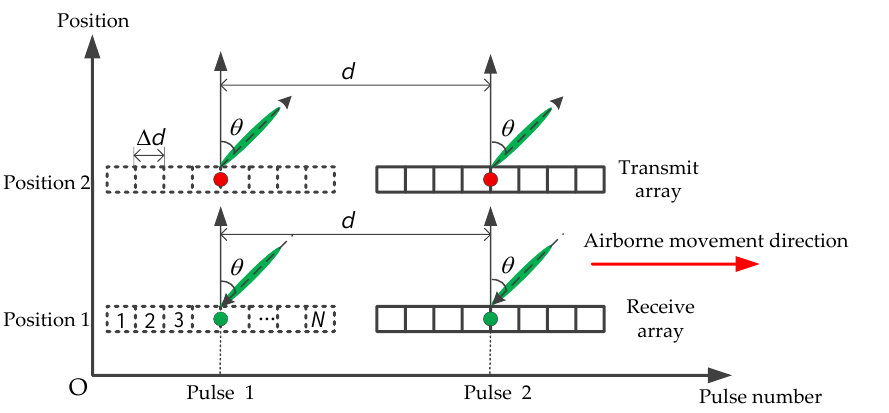
Figure 1. Schematic diagram of the airborne multichannel radar transmission and reception. In the very short transceiver time, the position 1 and 2 corresponding to the transmit array and the receive array are coincident, the distance that the airborne radar moves in a pulse repetition period interval (between pulse 1 and pulse 2) is d , and the echo signal s ( θ , m ) corresponding to the m -th pulse is proportional to the phase difference caused by the airborne motion (see Equation (2)). The phase term exp ( j 2 π md sin θ / λ ) is due to the difference in path between adjacent pulses which caused by the airborne platform motion.